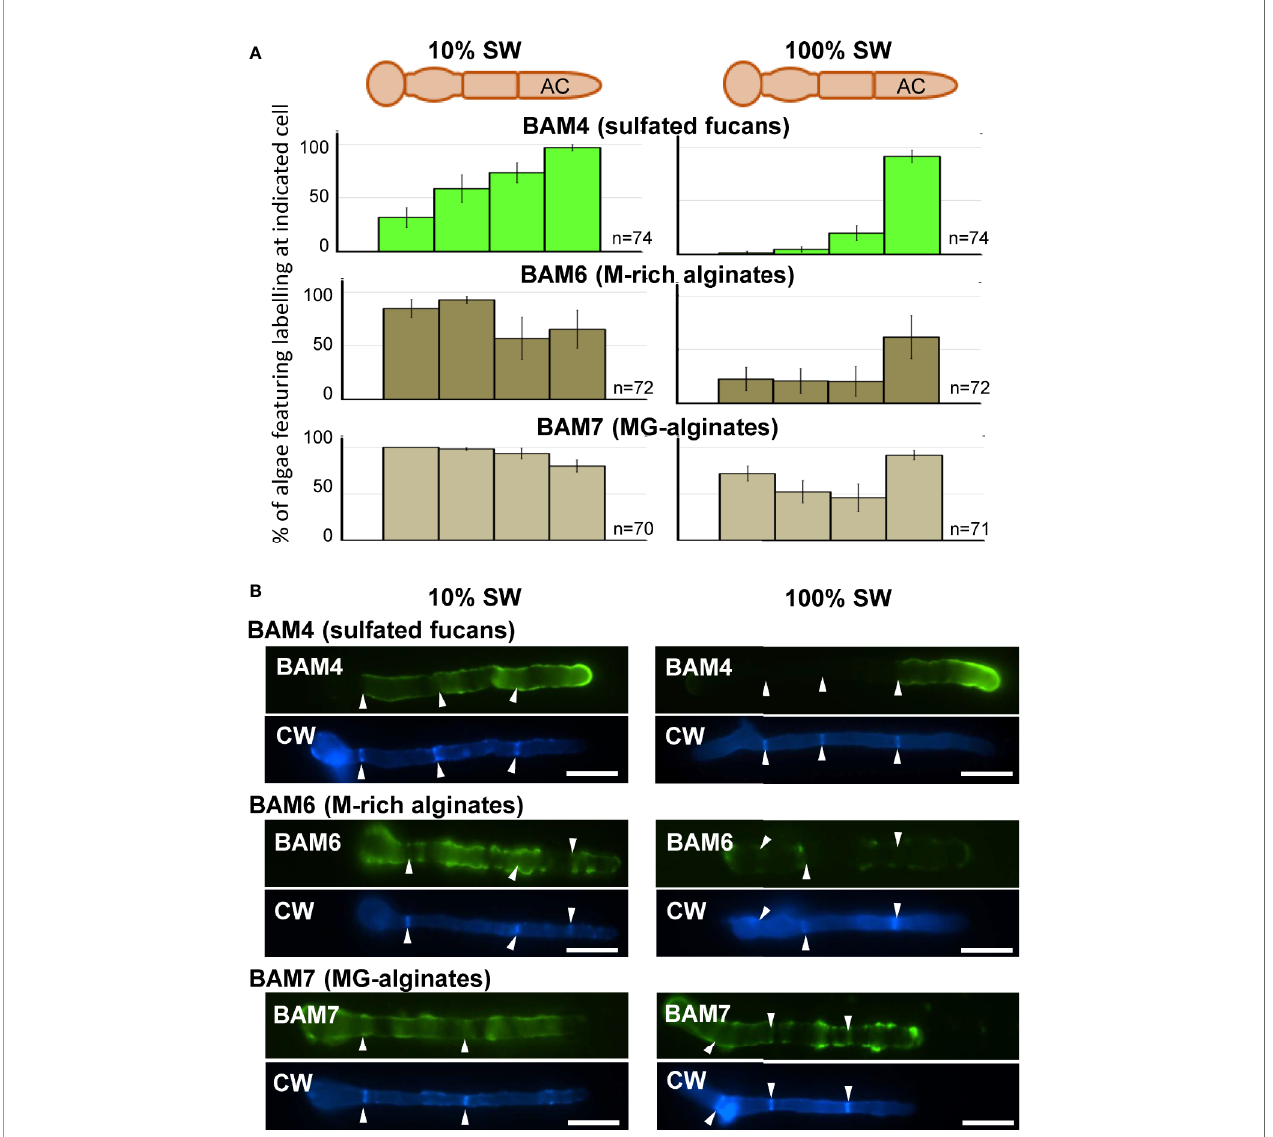
FIGURE 4 | Immuno fl uorescence detection of fucan and alginate epitopes in E. subulatus cultivated in seawater featuring distinct salinities. (A) Histograms showing the proportion of individuals showing BAM4 labeling at the indicated cells, as a function of the surrounding salinity. Apical cells were always strongly labeled. Scores for alginate detection are shown for comparison with BAM6 detecting M-rich alginates and BAM7 detecting MG-alginates. Compared to BAM4-fucan they indicate a broader occurrence of those epitopes along the fi laments. (B) Representative micrographs of individuals scored in (A) with the detection of fucan and alginate epitopes by the BAM antibodies (green fl uorescence) and cellulose detection by Calco fl uor White (blue fl uorescence). Scale bar = 20